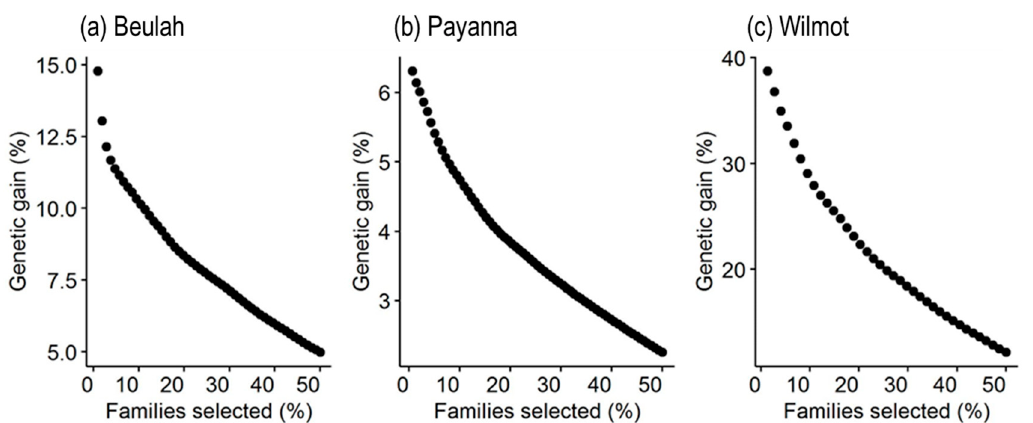
Figure 4. Predicted genetic gain (%) in reduction in the average amount of bark stripping as a function of the proportion of families selected in the different sites. Estimates are based on bark stripping for year 5 (2016) at ( a ) Beulah and ( b ) Payanna and at year 2 (2017) for ( c ) Wilmot.